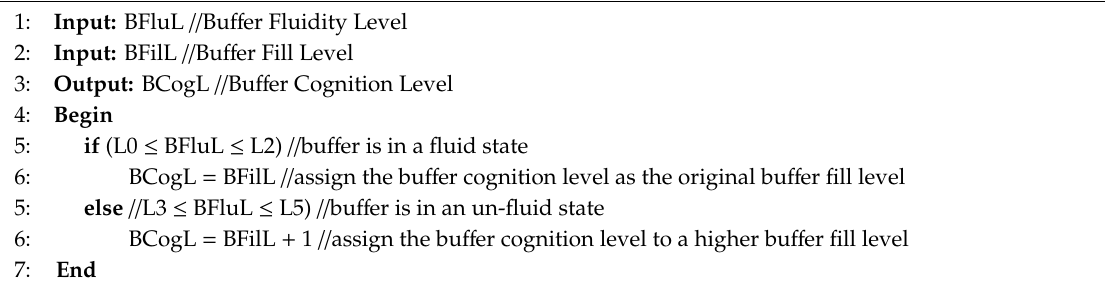
Algorithm 1 Bu ff er-Cognition-Level Congestion Control